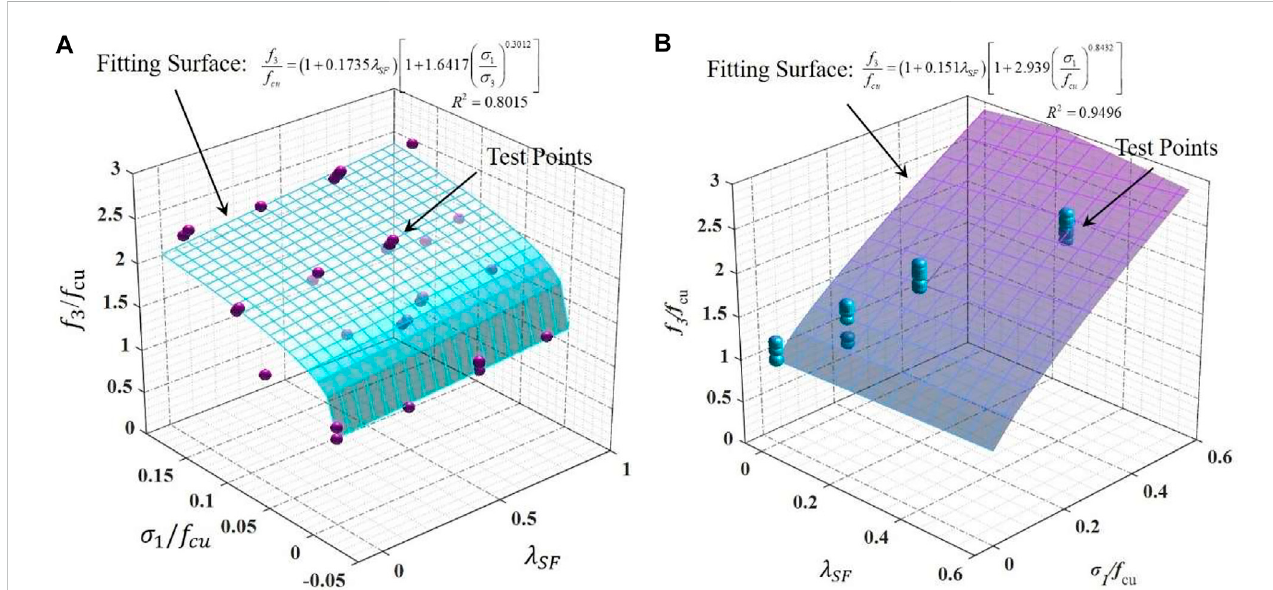
FIGURE 6 Comparisons between the test results and (A) The stress ratio-dependent fi tting surface, and (B) The con fi nement pressure -dependent fi tting surface.